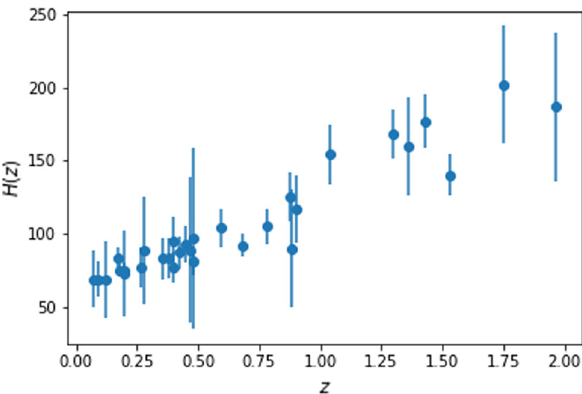
Fig. 1 The CC Hubble parameter data, H ( z ) , displayed in Table